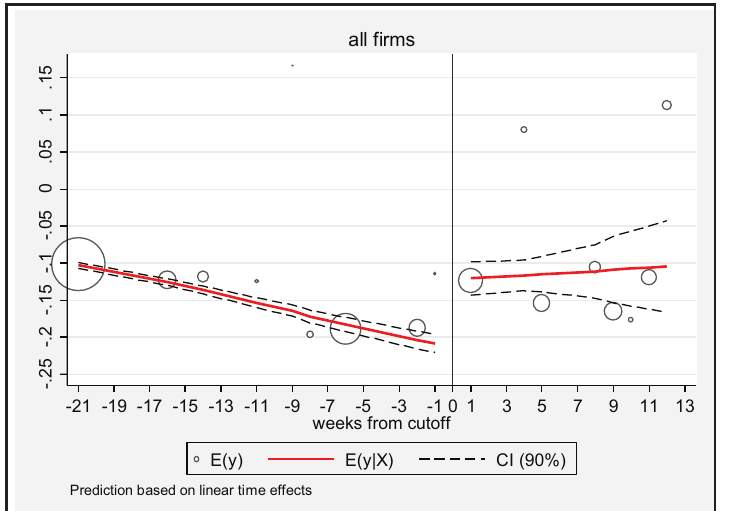
Figure 6 The overall effects of extensions on employment